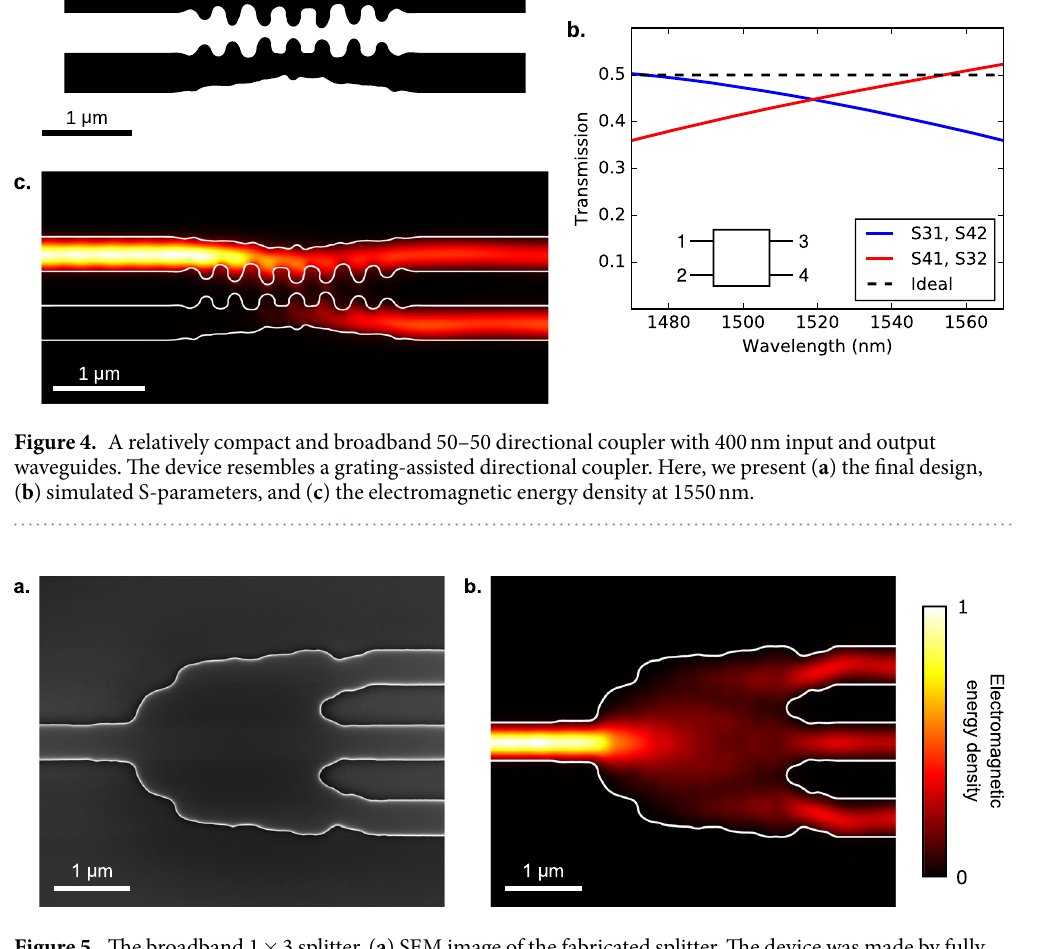
Figure 5. The broadband 1 × 3 splitter. ( a ) SEM image of the fabricated splitter. The device was made by fully etching the 220 nm device layer of an SOI wafer. The total footprint is 3.8 × 2.5 μ m. This image was taken before the devices were capped with oxide. ( b ) Electromagnetic energy density in the device at 1550